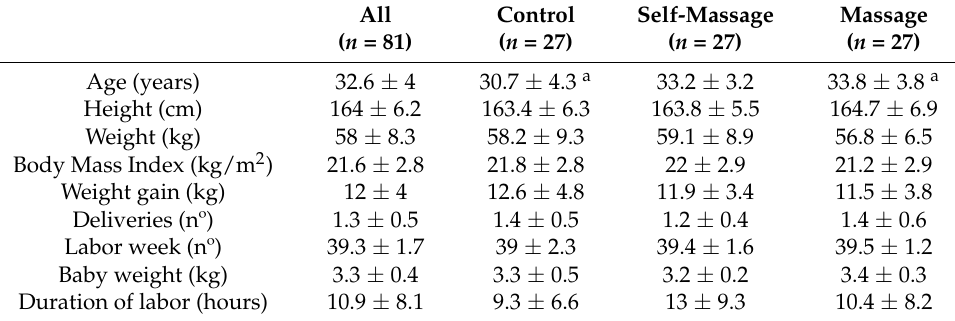
Table 1. Descriptive data of the sample (mean ± standard